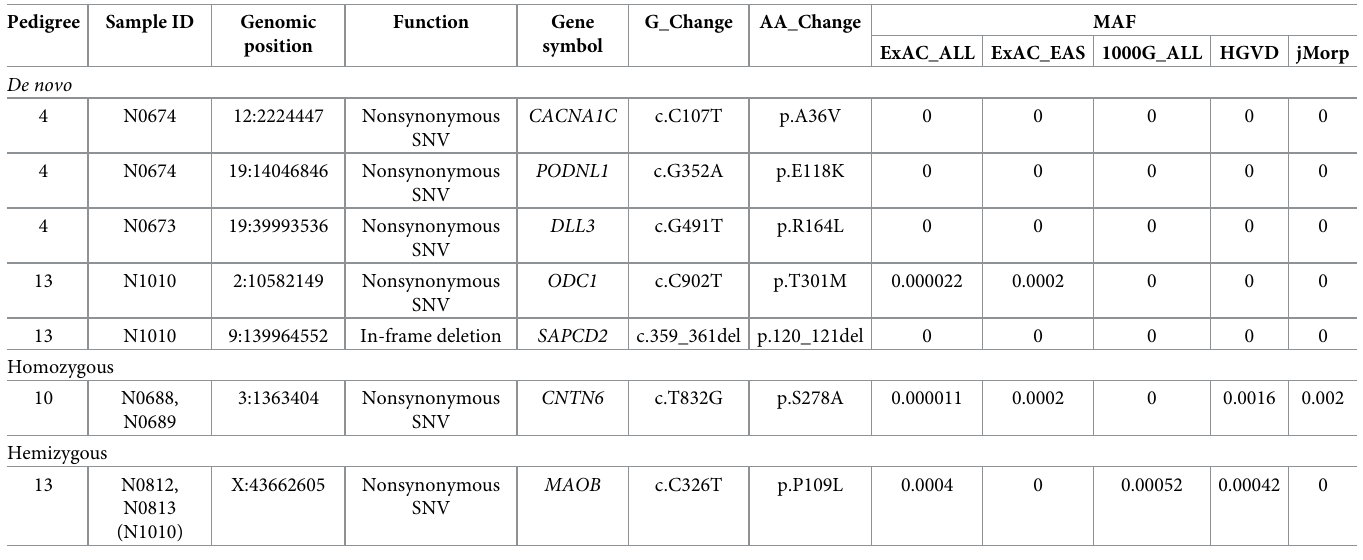
Table 2. Homozygous (hemizygous) and de novo